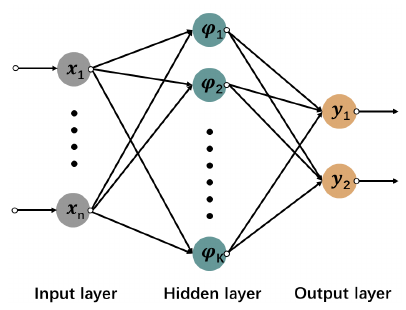
Figure 12. The structure of the RBF neural network.